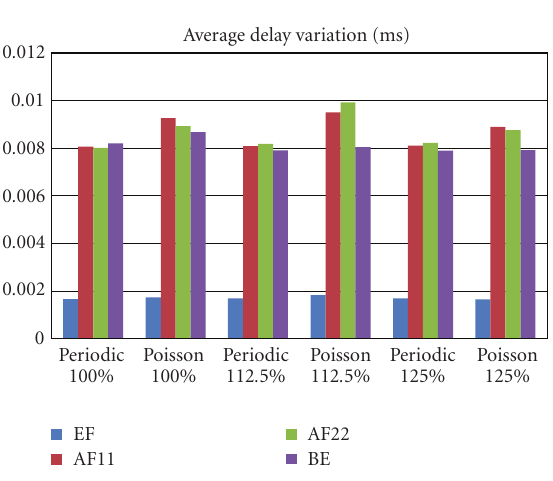
Figure 18: Average Delay